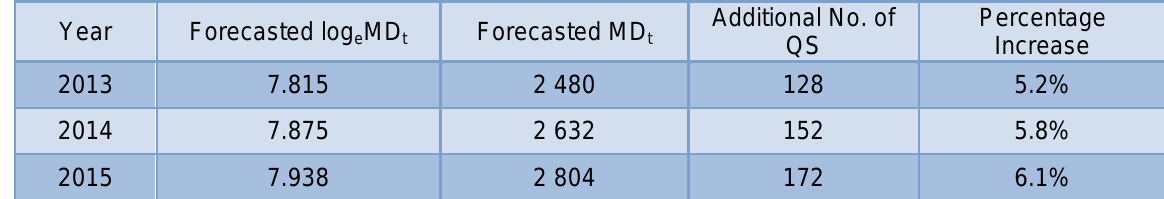
Table 5 Forecasted Manpower Demand for Quantity Surveyors Supply of Quantity